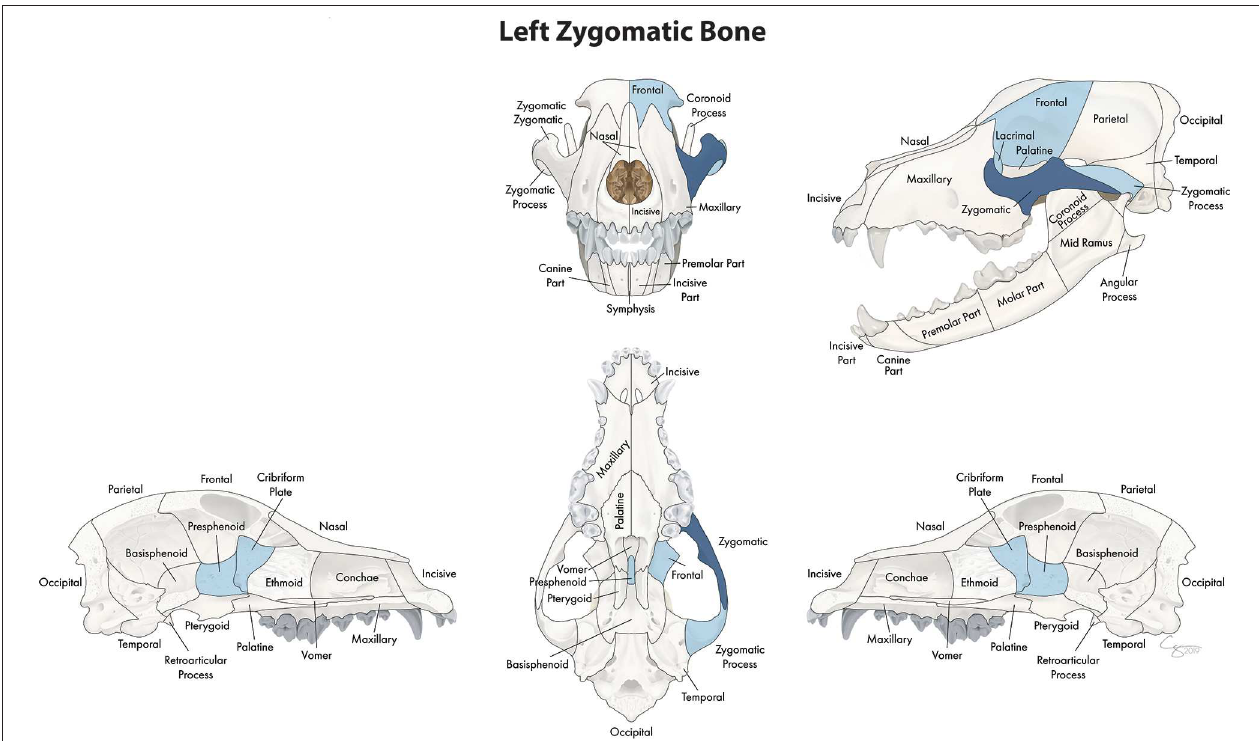
FIGURE 3 | Significant bones or regions fractured concurrently with the zygomatic bone. When the zygomatic bone was the region of interest, the cribriform plate, presphenoid, and ipsilateral zygomatic process, lacrimal, and frontal bones fractured concurrently. Although the left zygomatic bone is shown, when the right zygomatic bone was the region of interest, a mirror image of concurrently fractured locations applied. Only views of the skull that demonstrate a fractured region are